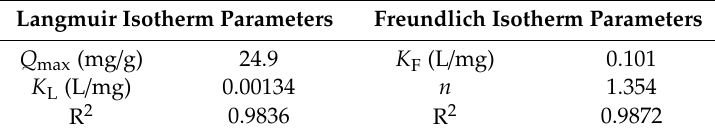
Table 3. Isotherm parameters for the adsorption of catechol on the g-C 3 N 4 / Fe 3 O 4 composite. Langmuir Isotherm Parameters Freundlich Isotherm Parameters